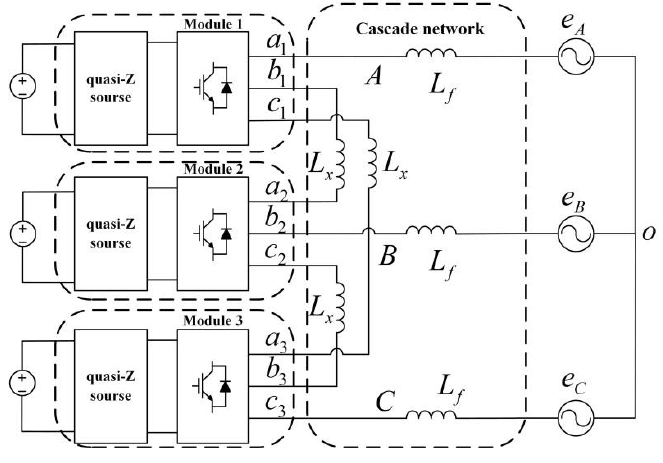
Figure 2. Main circuit topology of LVC-qZSI.